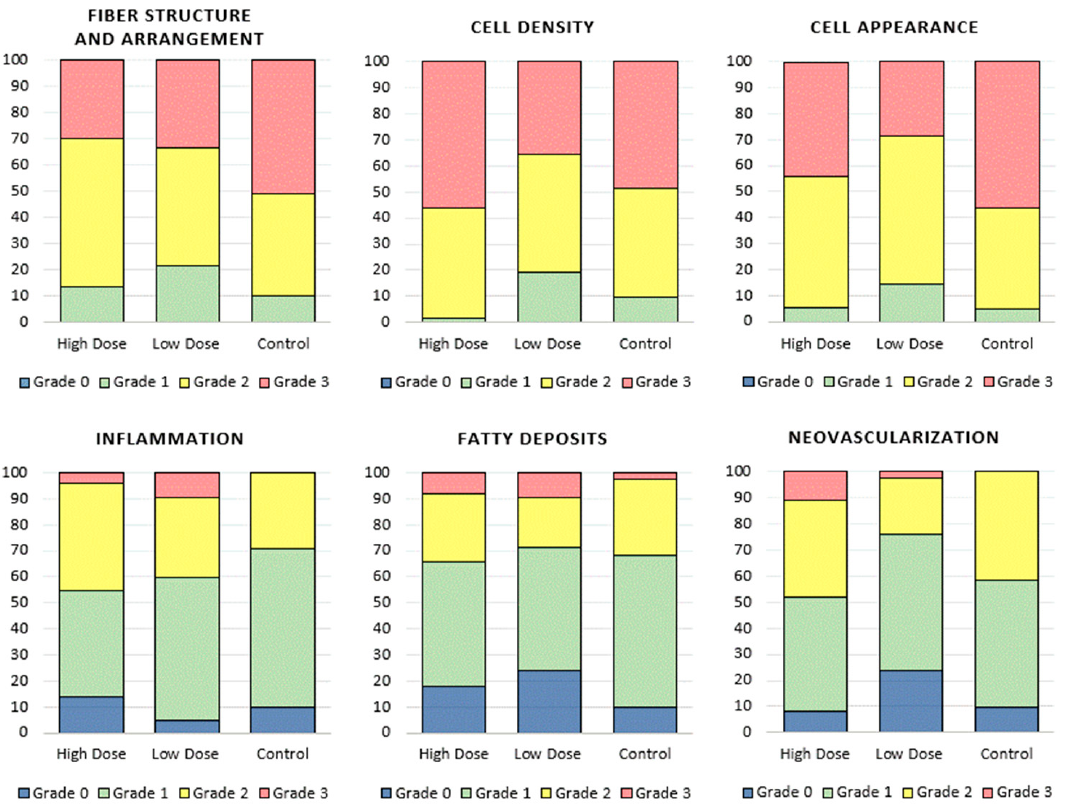
Figure 8. Results of histological grading (H&E) in terms of fiber structure, cell density, cell appearance, inflammation, neovascularization, and fatty deposits; color corresponds to histological grade and color bar height indicates the percentage of the indicated treatment group assigned that histological grade. No statistically significant differences in histological grade were detected between the high dose, low dose, and control groups in any